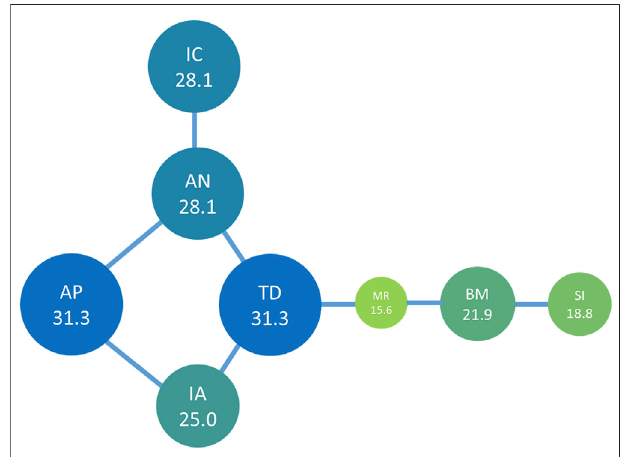
FIGURE 6 | Network analysis of the high frequency drug pairs found in Taiwanesebittertea.ThenumberistheUVoftheplantmaterial,andthelength of the connecting line indicates co-occurrence frequency. The circle sizes represent the relative ratio of UV. AN, Ajuga nipponensis Makino; IC, Ixeris chinensis (Thunb.) Nakai; IA, Ilex asprella (Hook. & Arn.) Champ.; TD, Tithoniadiversifolia (Hemsl.)A.Gray;MR, Mallotusrepandus (Willd.)Müll.Arg.; BM, Bombax malabarica DC.; SI, Solanum incanum L.; AP, Andrographis paniculat a (Burm. f.)